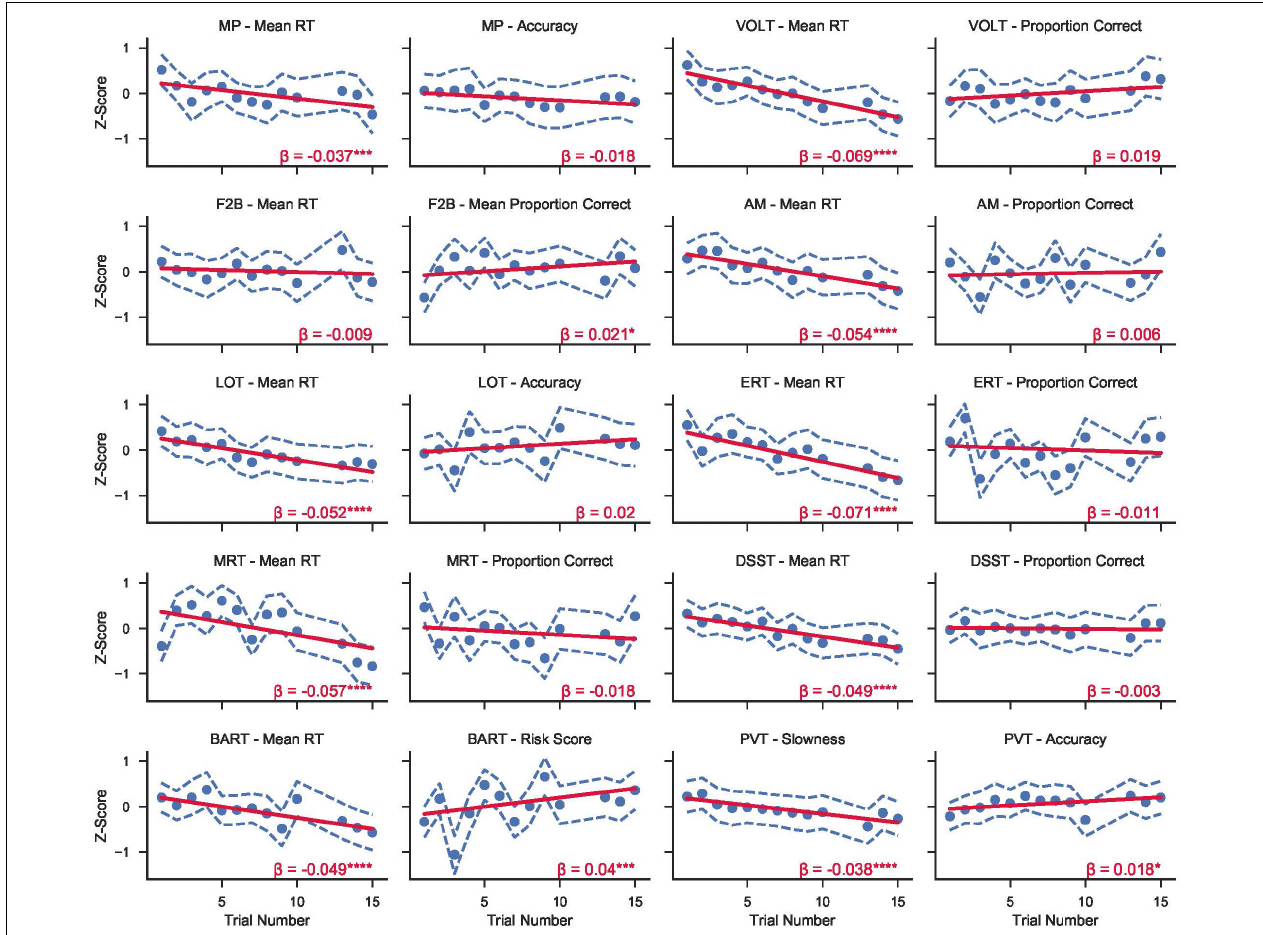
FIGURE 2 | Z-transformed standard speed and accuracy metrics from the 10 tests in the Cognition battery over time in mission across both campaigns at HERA. Circles refer to the mean score across subjects from both campaigns for each trial number. Dashed blue lines show the 95% CI range around each mean point. Solid red lines represent mixed effects linear models fit to the data for each variable. β refers to the linear slope of the regression model (i.e., change in z-score per trial). Asterisks refer to significance levels after adjusting for multiple testing with the false discovery rate method with p -values referring to H 0 : regression line slope = 0. (* p < 0.05; ** p < 0.01; *** p < 0.001; **** p <